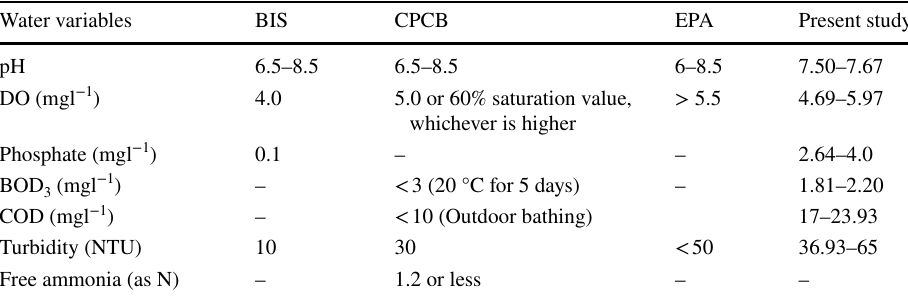
Table 5 Water quality standards for aquatic biodiversity